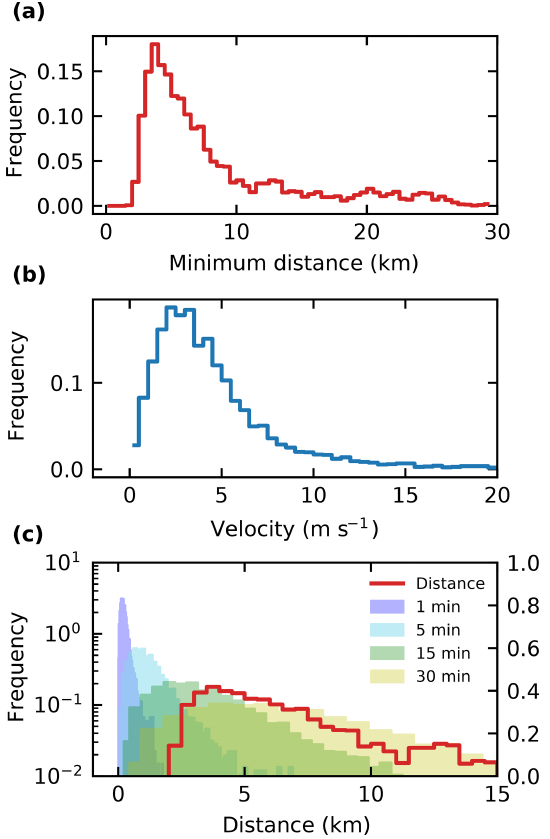
Figure 5. (a) Distributions of the distance to the next identified ob- ject for all identified objects and (b) velocities for tracked cloud objects at each time step of the trajectories. (c) The distribution of derived travel distances of individual clouds during one output time step (shaded colours) resulting from these velocities in (b) is shown together with the distribution of the minimal distance to the nearest neighbour for individual objects as shown in (a) .